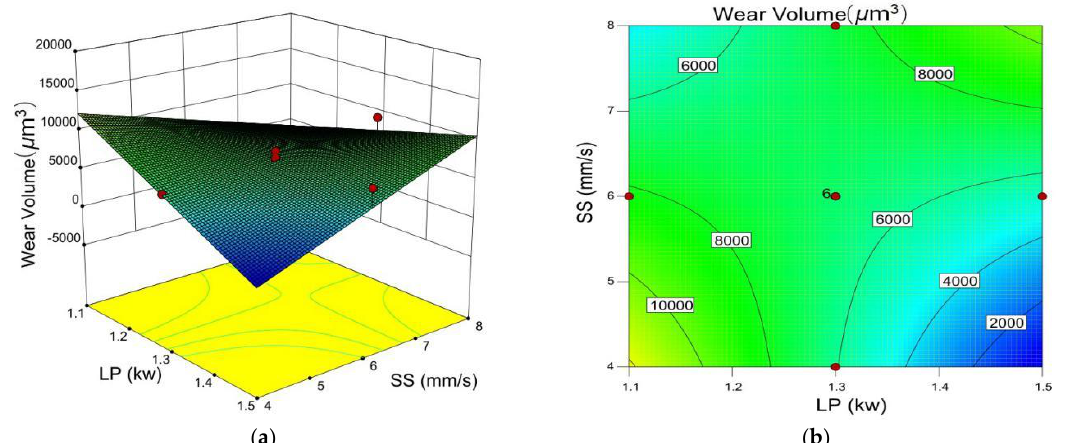
Figure 10. ( a ) 3D influence of laser power and scanning speed on wear volume. ( b ) Contour line of laser power and scanning speed on wear